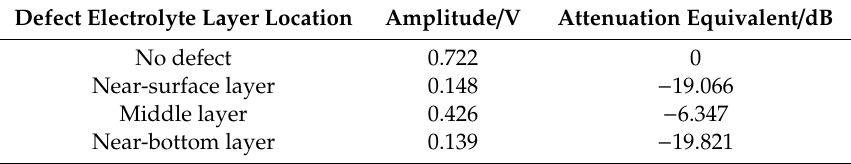
Figure 22. The contrast between the transmission signal of a near-bottom stomata defect of a lithium-ion battery and the transmission signal of an intact lithium-ion battery sample. ( A ) The transmission signal; ( B ) The corresponding frequency spectrum. Table 5. The acoustic attenuation equivalent of the actual ultrasonic transmission signal.